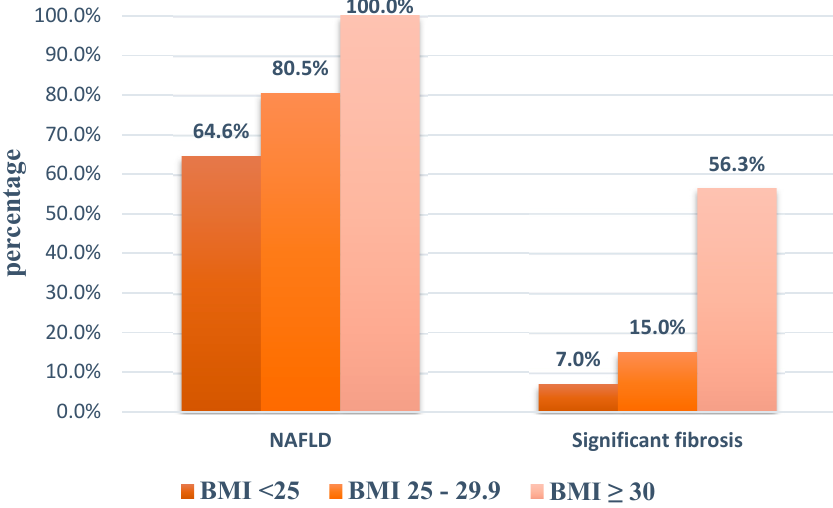
Figure 2. Proportion of patients with NAFLD and significant fibrosis according to BMI. (BMI, body mass index. NAFLD, non-alcoholic fatty liver disease).